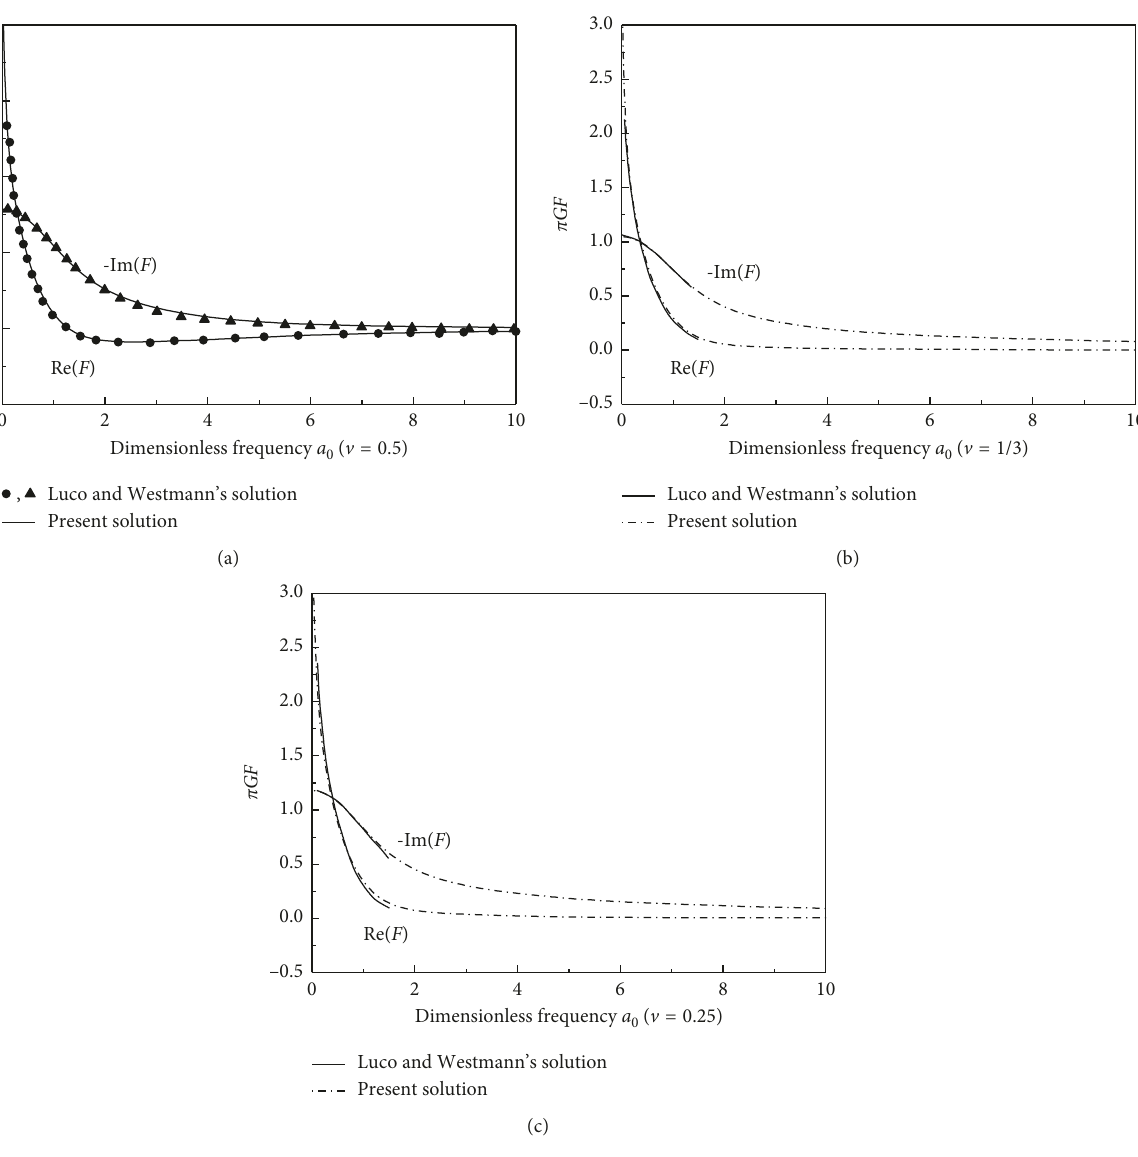
Figure 6: Vertical flexibility F ( a